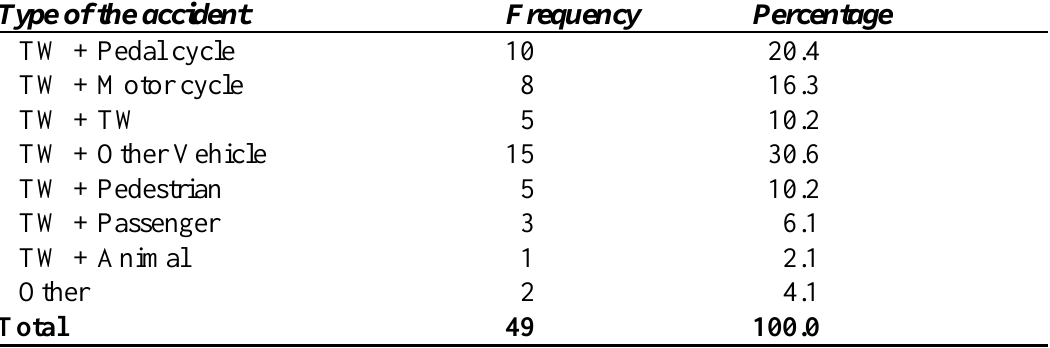
Frequency distribution of RTAs involving TWs by the type of the